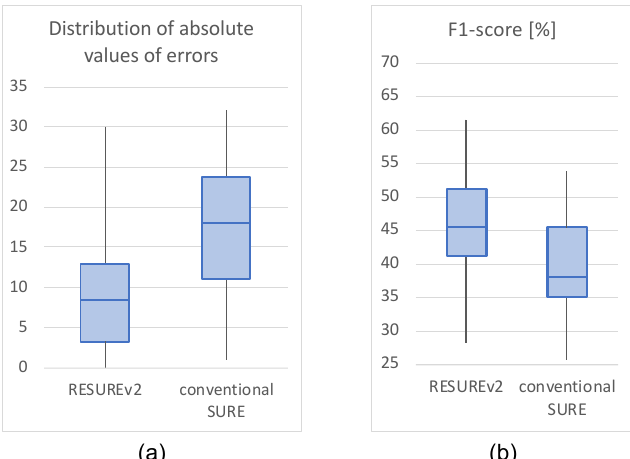
Figure 12. Performance comparisons of the proposed method with the conventional SURE-based method [16] by ( a ) the absolute values of estimation errors for the number of notes and ( b ) the F1-score performances. The top and bottom of the box indicate the third and first quartiles, respectively, and the horizontal bar inside the box indicate the median value. The ends of the vertical bar indicate the maximum and minimum values.